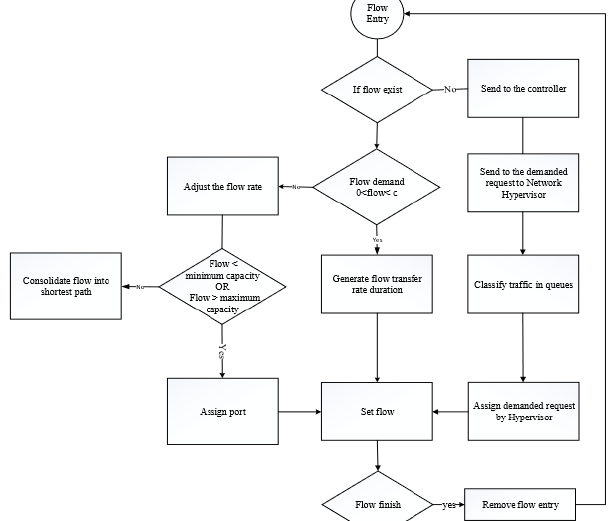
Fig. 4. Flow management of proposed solution (NPRA) for bandwidth allocation using virtual slice manager at BS and network